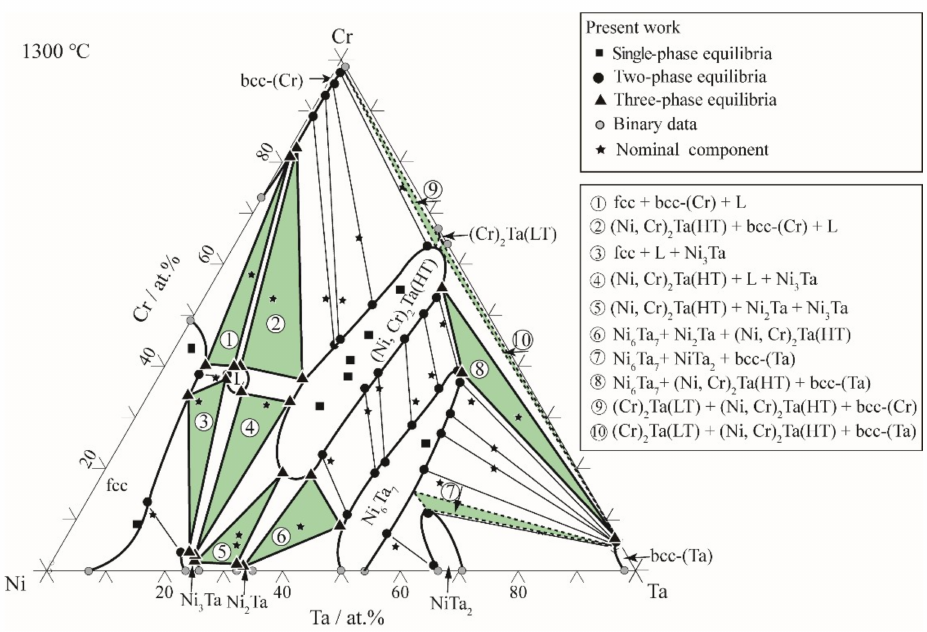
Figure 7. Experimentally determined isothermal section of the Ni-Cr-Ta system at 1300 ◦